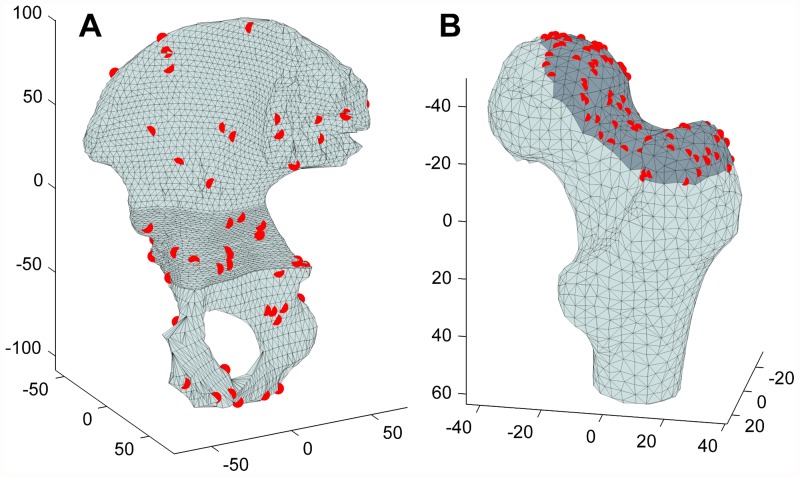
Human hip- and femur-bone meshes used in the registration studies.The red points represent a typical randomly generated source shape as sampled from the mesh surface. (A): The hip mesh is used in registration Experiments 2–5. (B): The femur mesh is used for the sub-shape registration study of Experiment 6, where points for the source shape are sampled from the shaded region of the mesh.